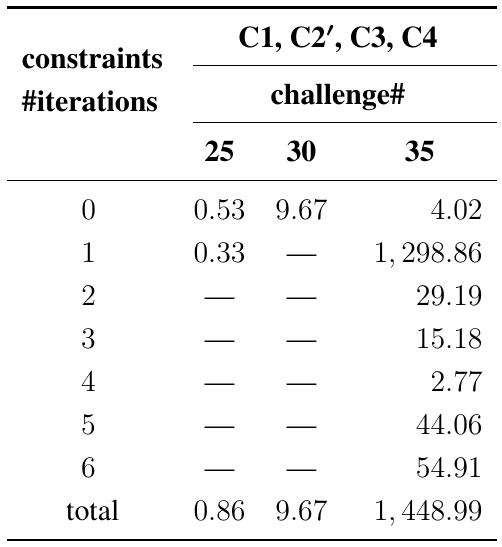
Table 3. Computational time (s) of solving IP formulations using C1, C2 ′ , C3 and C4 for challenge numbers 25, 30 and